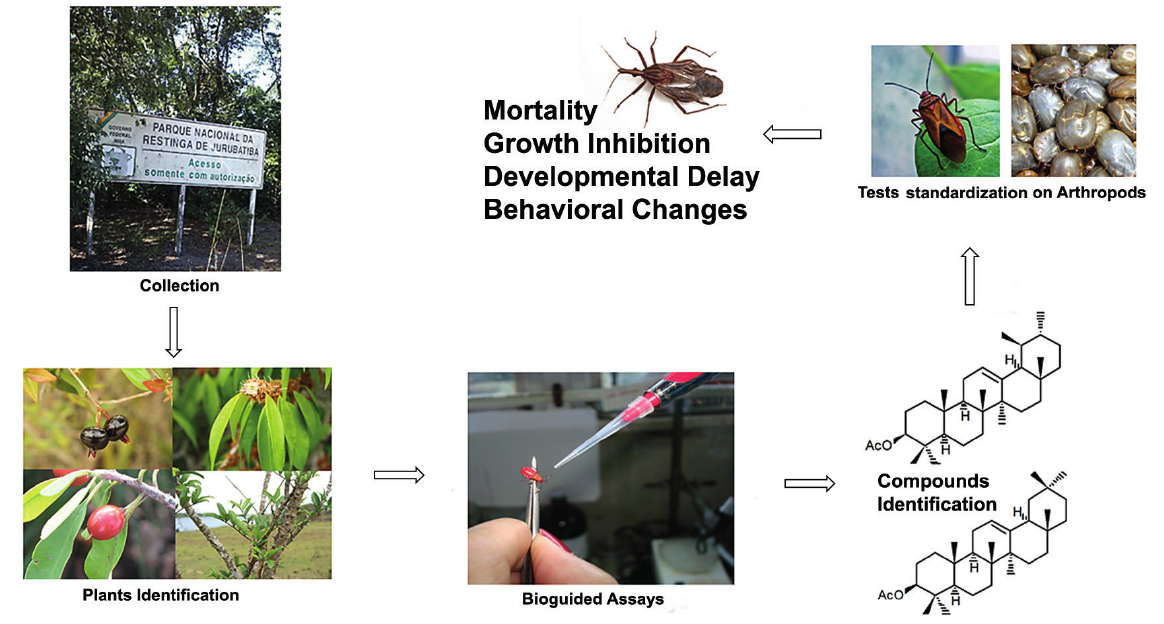
Figure 2 - Methodological Approach and experimental